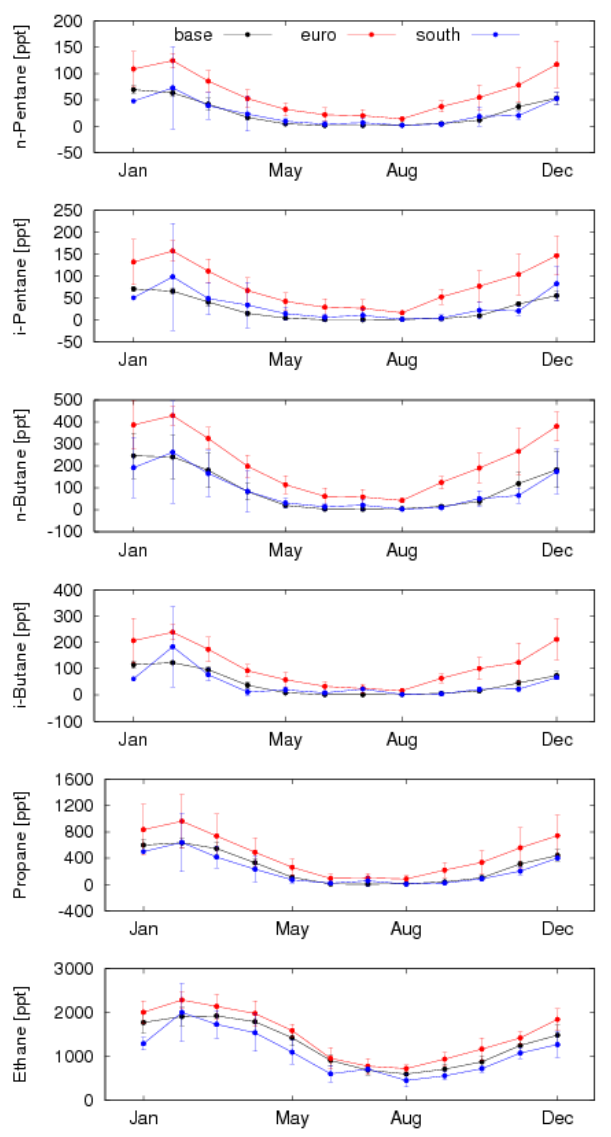
Figure 5: Monthly averaged data over the five year period from 2005-2009 separated into 2 Fig. 5. Monthly averaged data over the five year period from 2005– 2009 separated into baseline (black), European (red) and southerly baseline (black), European (red) and southerly transported (blue) air masses with error bars as 3 transported (blue) air masses with error bars as 1 σ 1 σ . 4